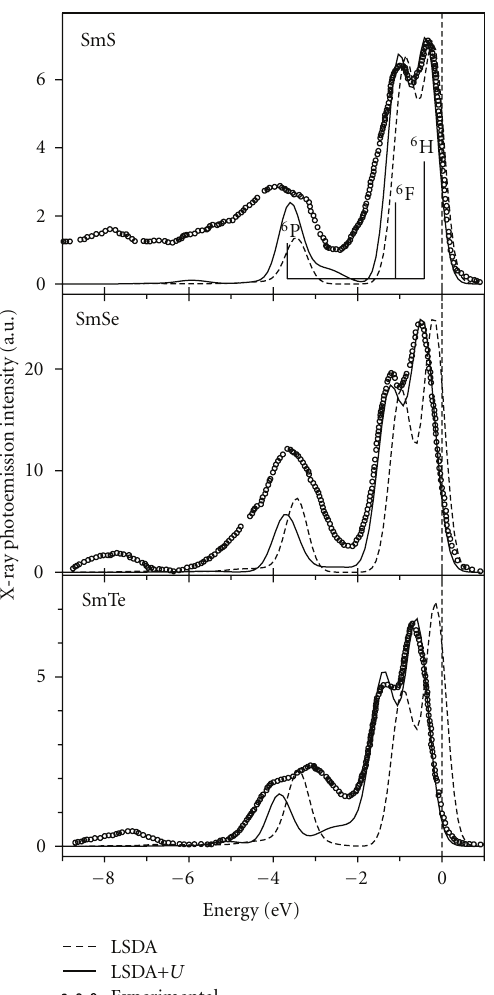
Figure 49: Comparison of the calculated 4 f DOS in LSDA and LSDA+ U approximations [313] with the experimental XPS spectra from [314] taking into account the multiplet structure of the 4 f 5 final state (see explanations in the text).